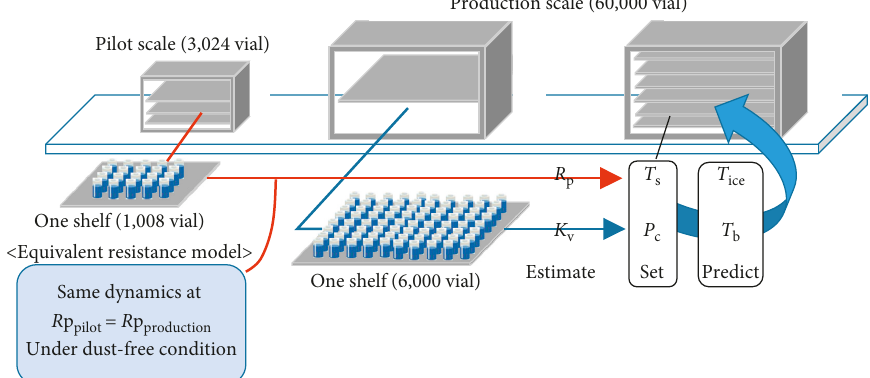
Figure 5: Scale-up theory based on the equivalent resistance model [55]. In this illustration, the equipment of the pilot scale can ac- commodate the three shelves. The equipment of the production scale accommodates ten